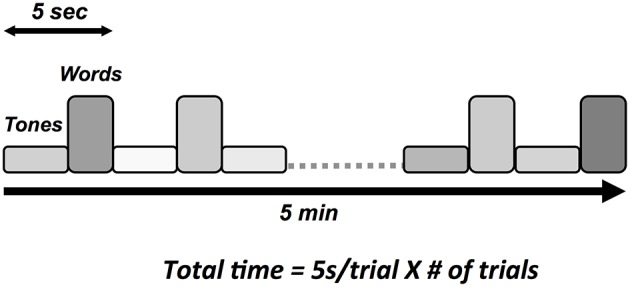
Schematic illustration of auditory stimulus sequence consisting of words and tones.